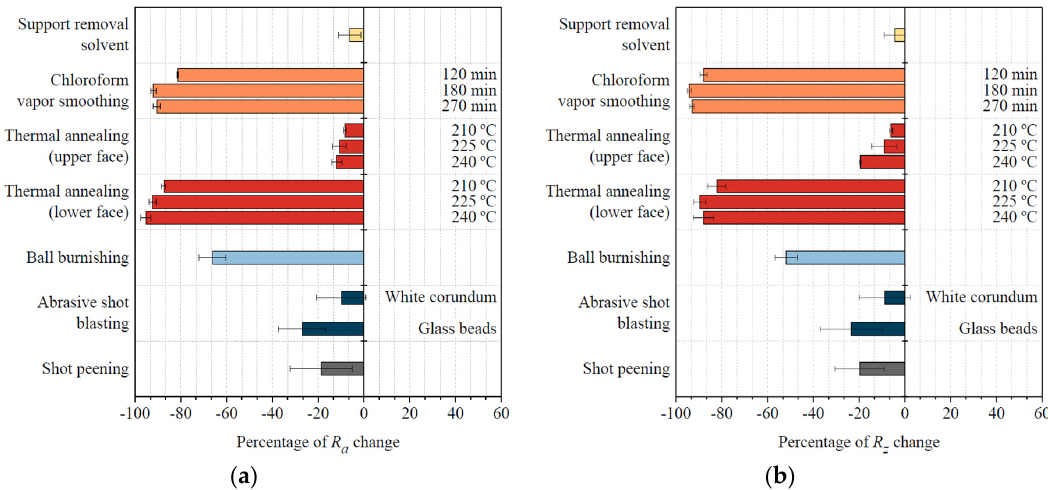
Figure 1. ( a ) Changes in average surface roughness; ( b ) Changes in average peak-to-valley height of the roughness